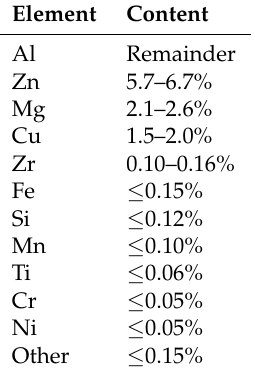
Table 3. Al 7010-T6’s chemical composition.